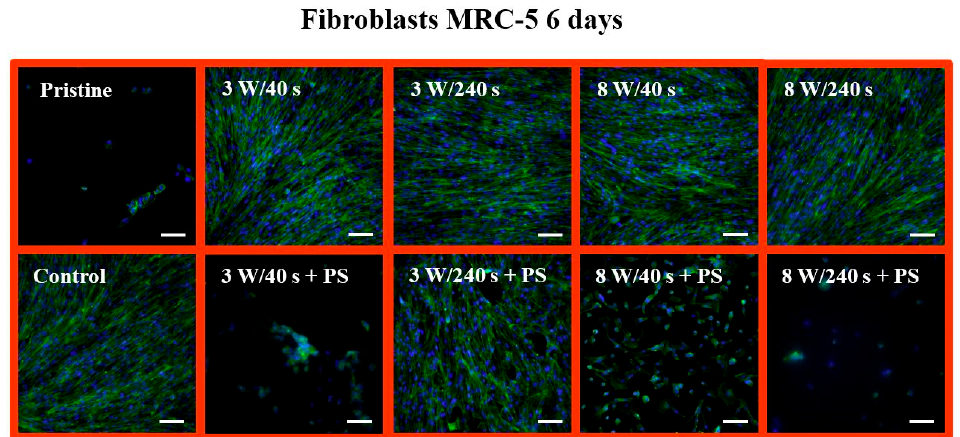
Figure 14. Fluorescence microscopy images of primary human fibroblasts (MRC-5) at 6 days post- seeding on FEP (pristine), FEP matrices treated using plasma with 3 and 8 W (40 and 240 s) and subsequently coated with a honeycomb-like pattern formed from PS. As a control, a glass coverslip was used. Nuclei stained with DAPI are in blue, F-actin labeled with phalloidin-Atto 488 is in green. The scale bars represent 100 µm.